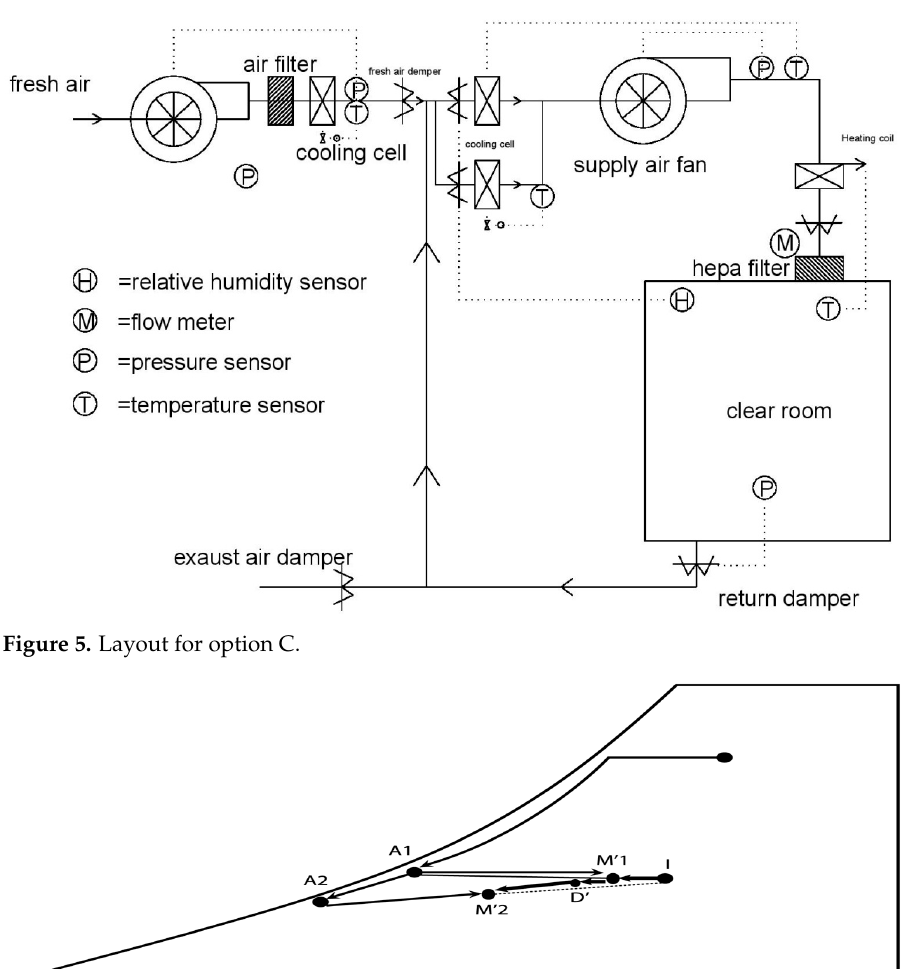
Figure 6. Psychometric chart for option